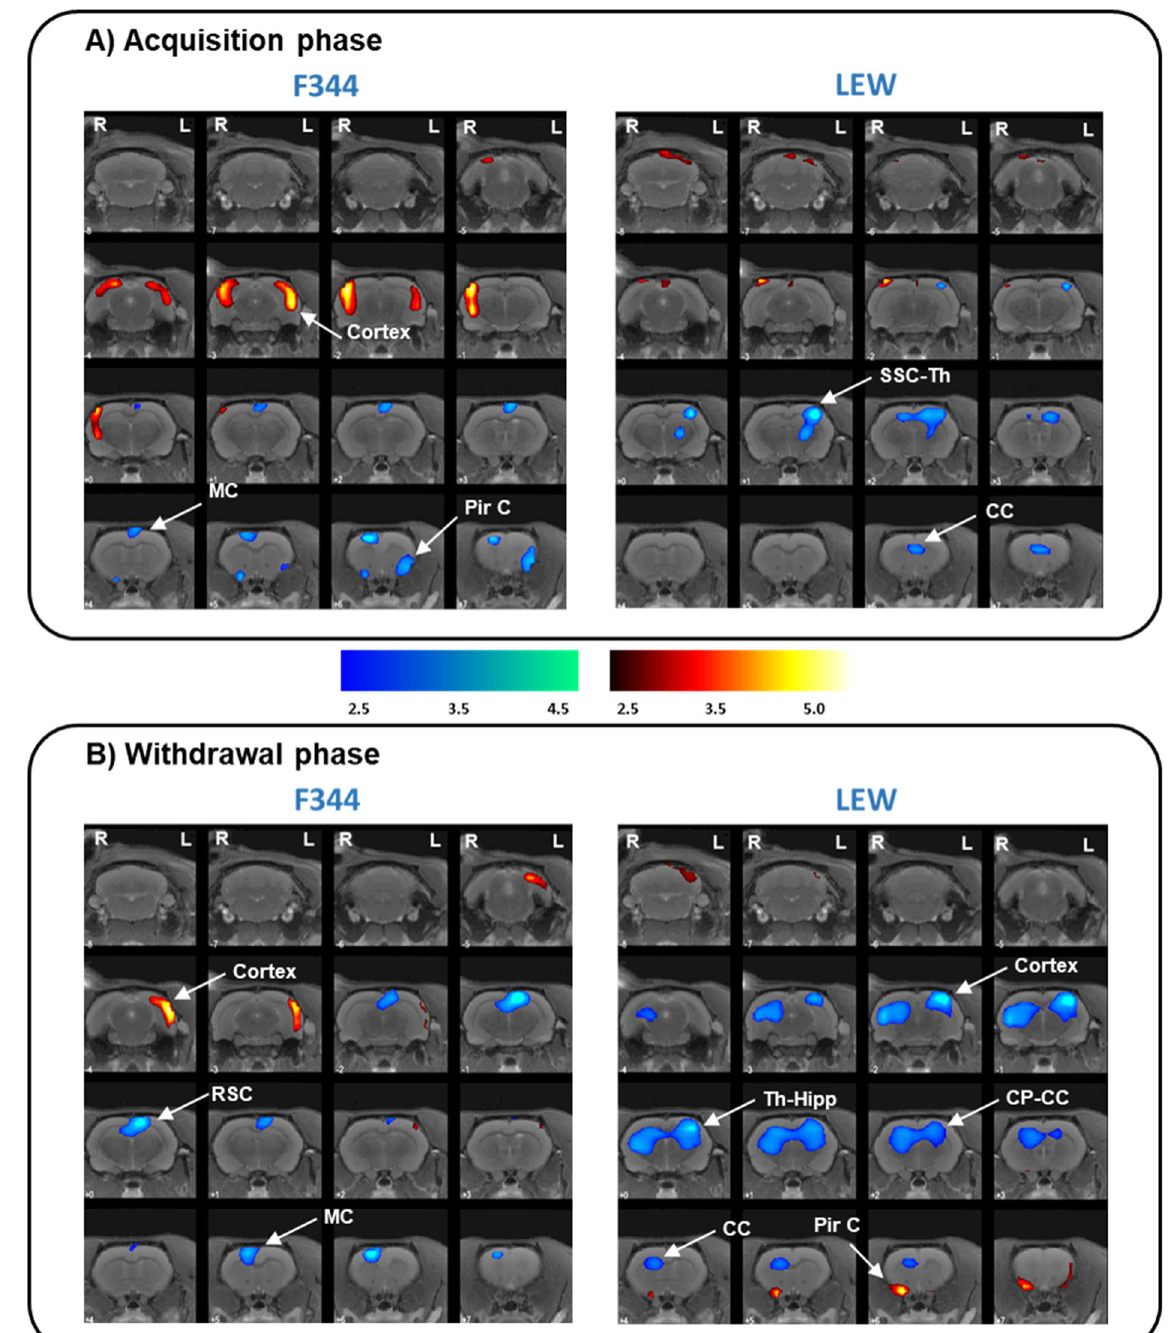
Figure 2. Brain glucose metabolism patterns associated with morphine consumption in F344 and LEW rat strains. PET results in T-maps overlaid on a T2-MRI reference showing increased FDG uptake (hot colors) or decreased FDG uptake (cold colors). PET results in the F344-morphine (left) and LEW-morphine (right) animals compared to the Sal-F344 and Sal-LEW animals respectively, in the acquisition phase (A) and the withdrawal phase (B). (A) F344-morphine animals showed higher FDG uptake in the cortical area and lower FDG uptake in the motor and piriform cortex than the F344- saline animals. LEW-morphine animals showed lower FDG uptake in the somatosensorial and cingulate cortex and thalamus and higher FDG uptake in the cerebellum than the LEW-saline animals. (B) F344-morphine animals showed higher FDG uptake in the left cortex and lower FDG uptake in the restrosplenial and motor cortices than the F344-saline animals. LEW-morphine animals showed higher FDG uptake in the cerebellum and piriform cortex and lower FDG uptake in the cortex, thalamus, hippocampus, and caudate putamen than the LEW-saline animals. LEW-saline (n = 5), LEW- morphine (n = 6), F344-saline (n = 7), and F344-morphine (n = 6). Threshold for statistical significance of p < 0.01. Region of interest (C: cortex, CC: cingulate cortex, Cb: Cerebellum, CP: caudate putamen, Hipp: hippocampus, MC: motor cortex, PirC: piriform cortex, RSC: retrosplenial cortex, Sept: septum, SSC: somatosensorial cortex; Th: thalamus). Side: left (L) and right (R). k: cluster size, T: Student t. FDG uptake: increase ( ↑ ) and decrease ( ↓ ). p: p value (unc: uncorrected, FWE: family‑wise